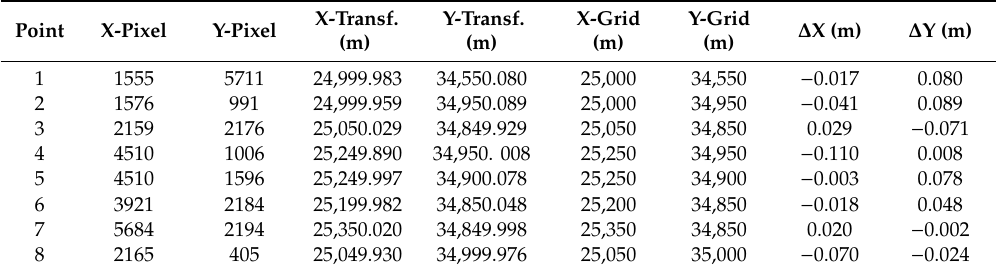
Table 3. Transformed coordinates from pixel coordinates in bilinear model, grid coordinates, and di ff erences in between.